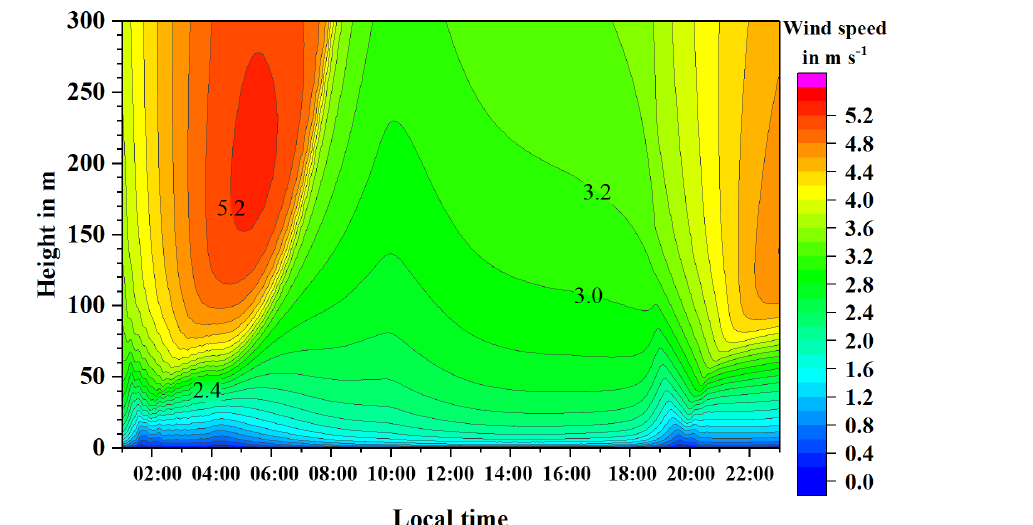
Figure 2. Daily course of wind speed profiles simulated by HIRVAC2D for a cloudless summer day (19 June) over a homogeneous grassland site for vg = 4ms − 1